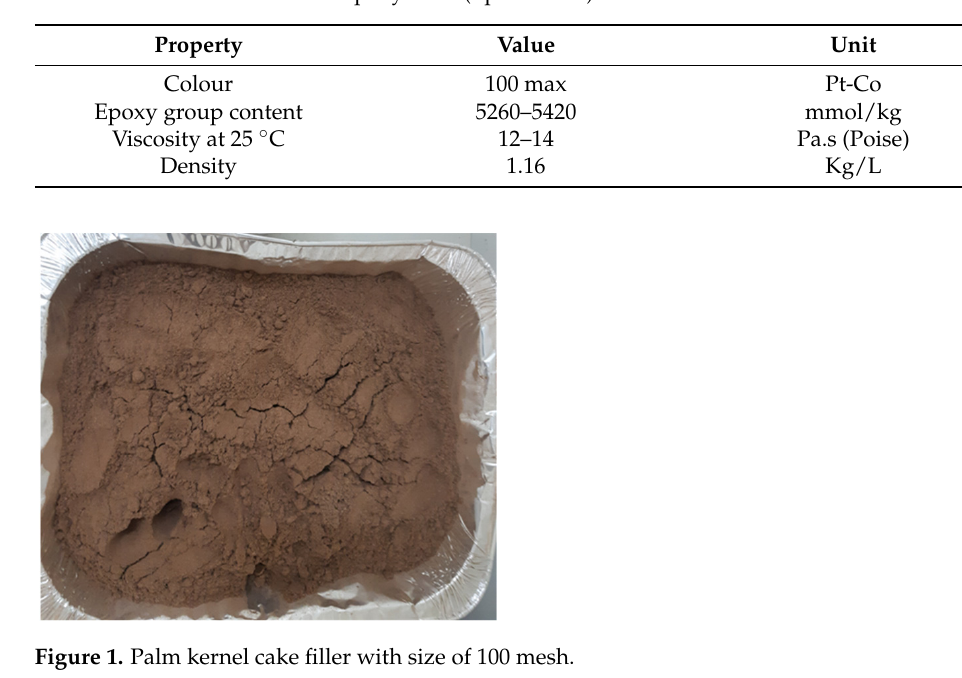
Table 1. Technical datasheet of epoxy resin (Epikote 828).